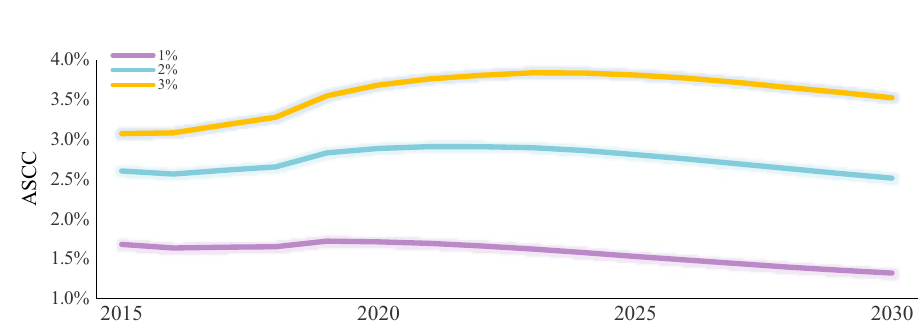
Fig. 9 The ITC impact on the average social cost of carbon